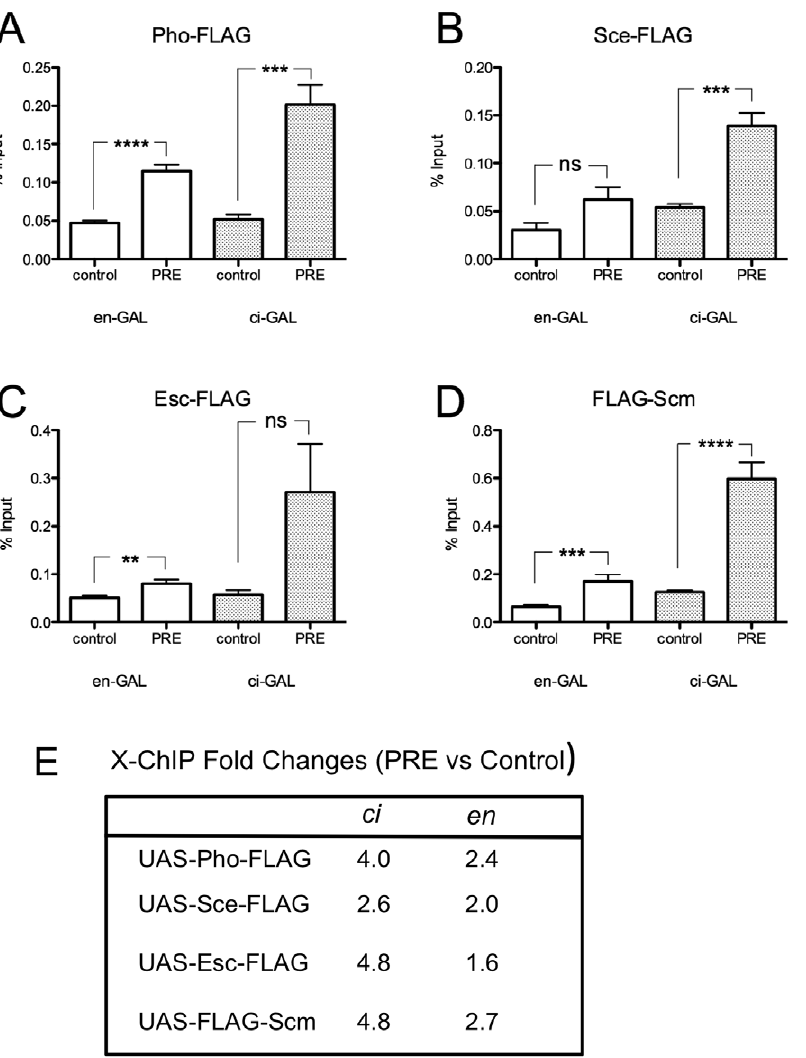
Figure 5. FLAG-tagged PcG proteins are bound to the en PRE in both the ‘‘ON’’ and ‘‘OFF’’ transcriptional states. (A–D) X-ChIP (with a - FLAG) was performed on third instar imaginal discs and CNS, with en -GAL4 or ci -GAL4 driven Pho-FLAG (A), Sce-FLAG (B), Esc-FLAG (C), FLAG-Scm (D). Results are shown as a percentage of the input DNA, collected prior to ChIP. ns=not significant, * P # 0.05, ** P # 0.01, *** P # 0.001, **** P # 0.0001 (un-paired, two-tailed t-tests). Results shown are from three independent biological samples with 2 replicates each. (E) Fold increase (PRE/control) using the means from the experiments shown in A–D. The UAS-lines are shown on the left, with the drivers en -Gal4 ( en ) and ci-Gal4 ( ci ) on top.